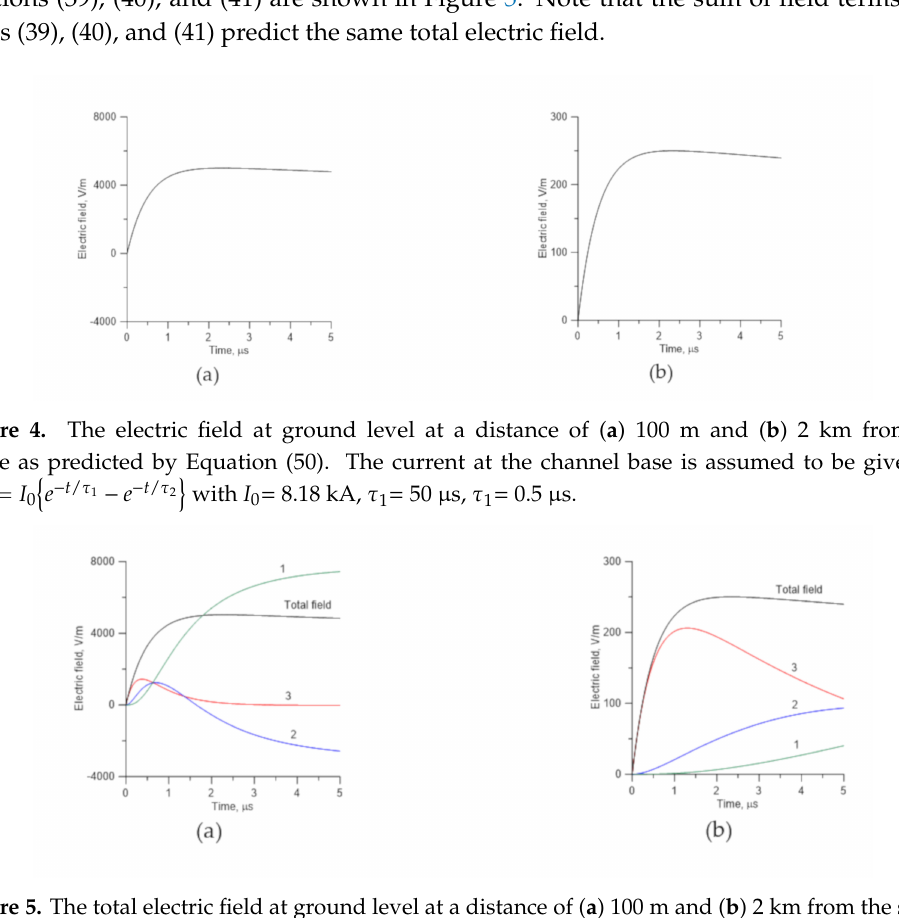
Figure 5. The total electric field at ground level at a distance of ( a ) 100 m and ( b ) 2 km from the strike as predicted by Equation (39). The three field components (i.e., Equations 39, 40 and 41), namely, static, induction and radiation are also shown separately by curves 1, 2 and 3, respectively. The current at the (cid:110) (cid:111) e − t / τ 1 − e − t / τ 2 channel base is assumed to be given by I ( t ) = I 0 with I 0 = 8.18 kA, τ 1 = 50 µ s, τ 1 = 0.5 µ